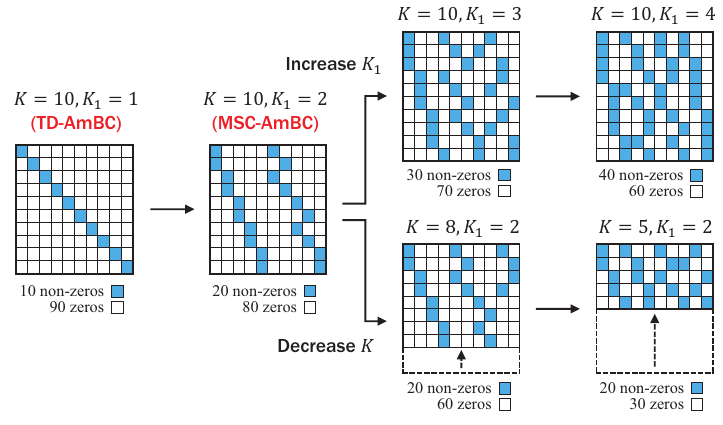
Figure 6. Example of the factor graph design when N =